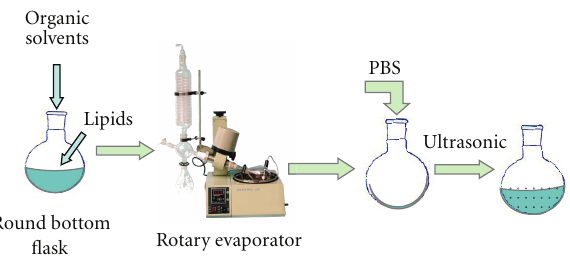
Figure 3: Conventional liposome preparation method: film disper- sion